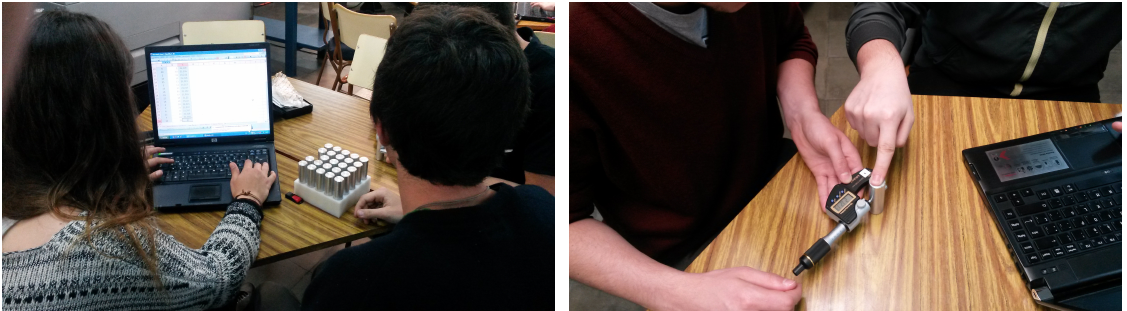
Figure 1. Students in the measurement